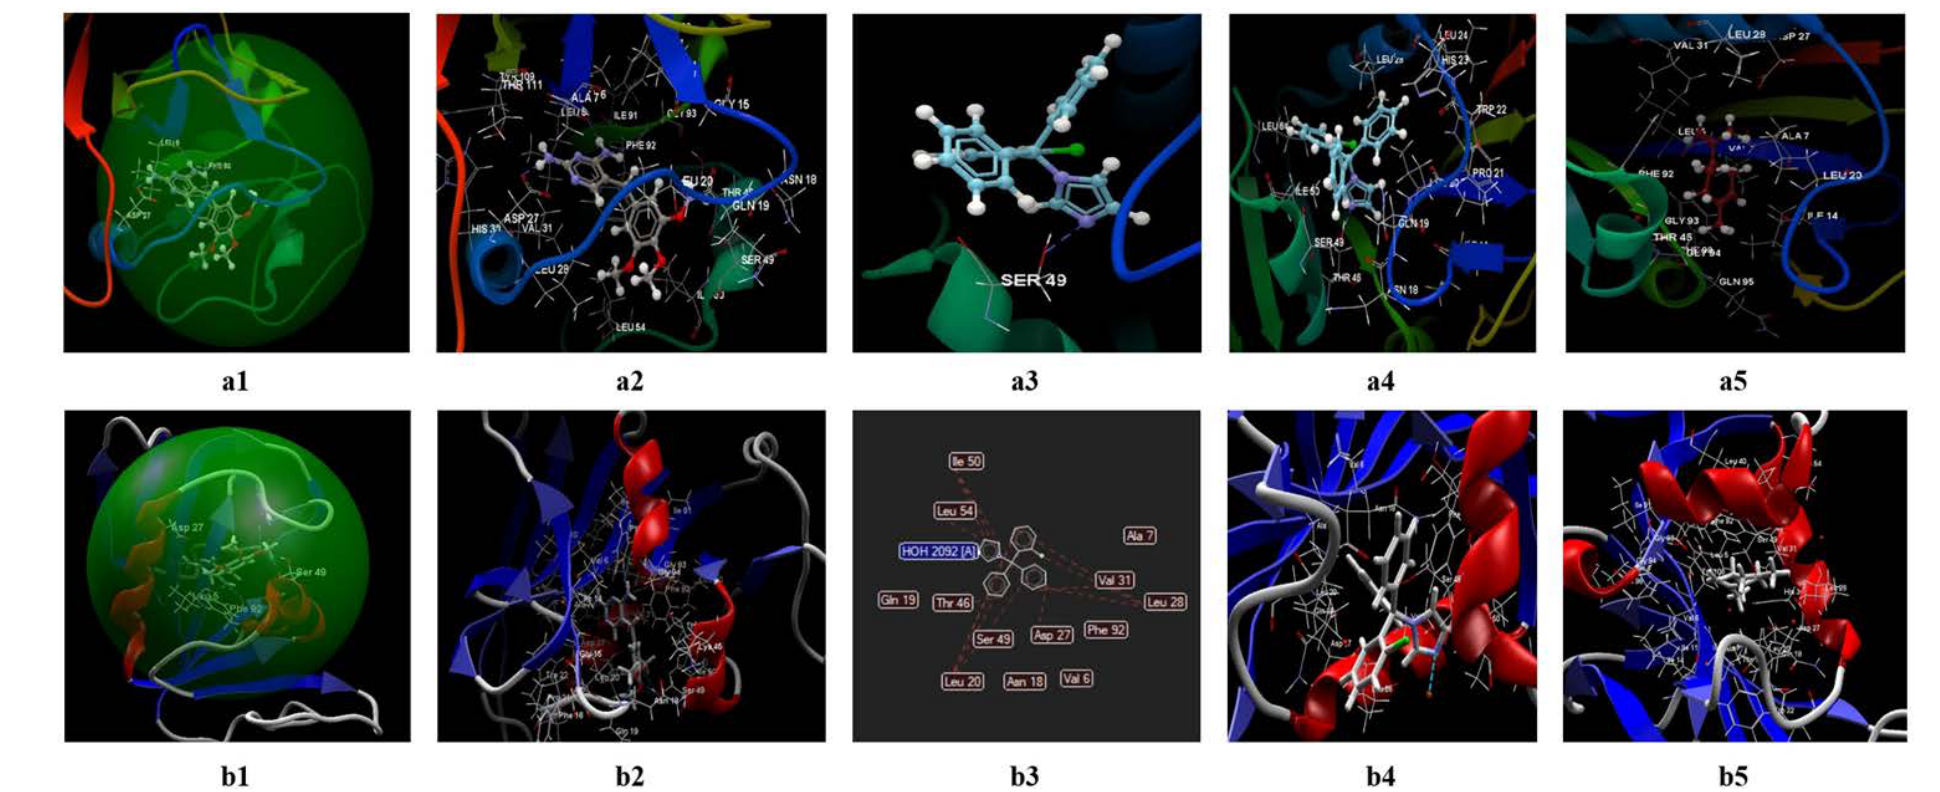
Figure 9. Molecular docking of co-crystallized (TOP), limonene, and clotrimazole for S. aureus in binding site 2W9H. ( a1 ) Docking of the co-crystallized TOP (score: − 53.12; RMSD 0.35) in the binding site of 2W9H (model generated by CLC); ( b1 ) docking of the co-crystallized TOP (score: − 100.32; RMSD 0.00) in the binding site of 2W9H (model generated by MOLEGRO); ( a2 ) interactions between the co-crystallized TOP and the amino acid residues in the binding site 2W9H (model generated by CLC). The blue lines represent the hydrogen bonds; ( b2 ) interactions between the co-crystallized TOP and the amino acid residues in the binding site of 2W9H (model generated with MOLEGRO). The blue lines represent the hydrogen bonds; ( a3 ) hydrogen bonds (blue dotted lines) between clotrimazole and SER 49 amino acid in the binding site 2W9H, generated by CLC; ( b3 ) hydrogen bonds (blue) and steric interactions (red) between clotrimazole and amino acids in the binding site 2W9H in the 2D format, generated by MOLEGRO; ( a4 ) the interactions between the clotrimazole and the amino acid residues in the binding site 2W9H, generated by CLC; ( b4 ) hydrogen bonds and steric interactions, between clotrimazole and the amino acids, in the binding site 2W9H, generated by MOLEGRO; ( a5 ) interactions of limonene with the amino acid residues in the binding site of 2W9H, generated by CLC; ( b5 ) interactions of limonene with the amino acid residues in the binding site 2W9H, generated by